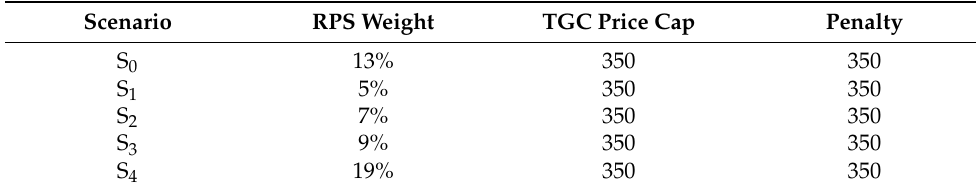
Table 2. Scenarios for analyzing the impact of RPS